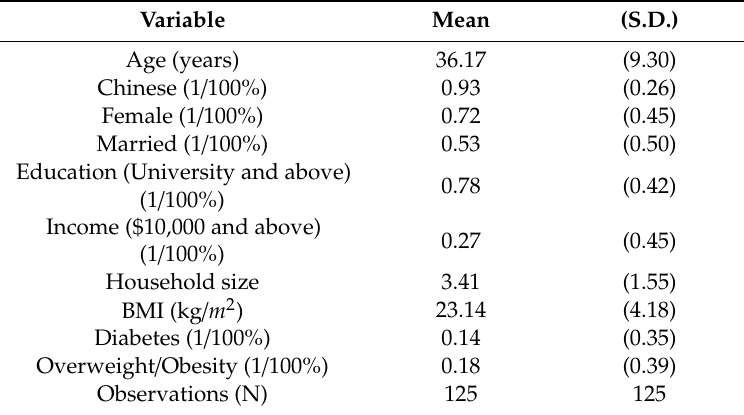
Table 1. Participant summary statistics.